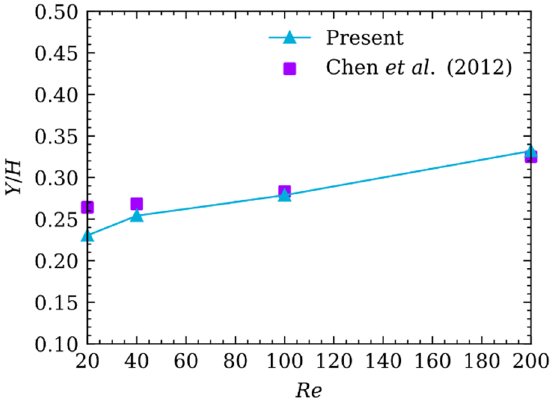
Figure 5. Comparison of TEPs of the particle migrating in Poiseuille flow at different 𝑅𝑒 .